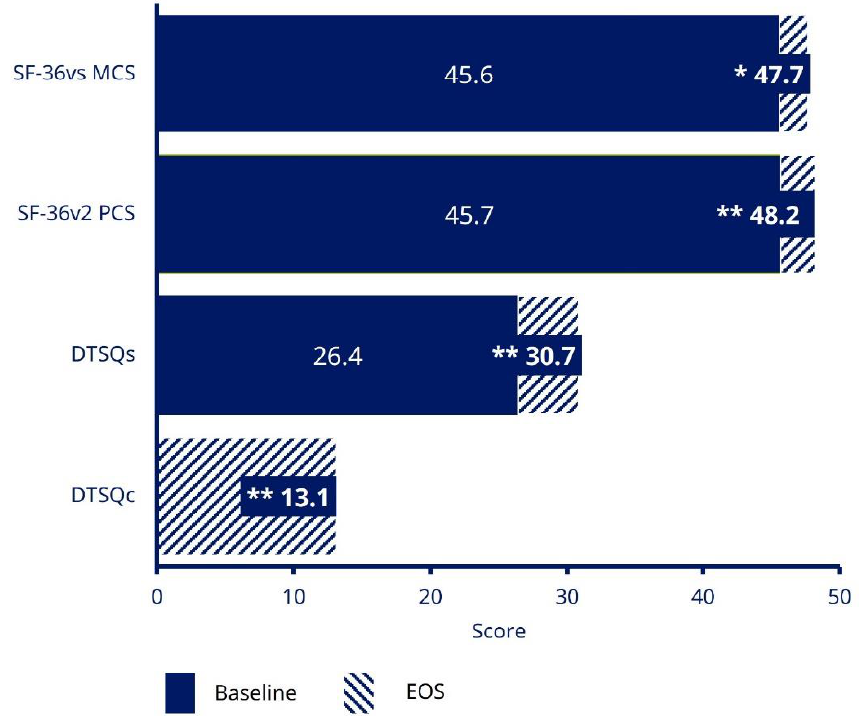
Figure 3. Treatment satisfaction and HRQoL (EAS). * p = 0.0013; ** p < 0.0001. Data are based on